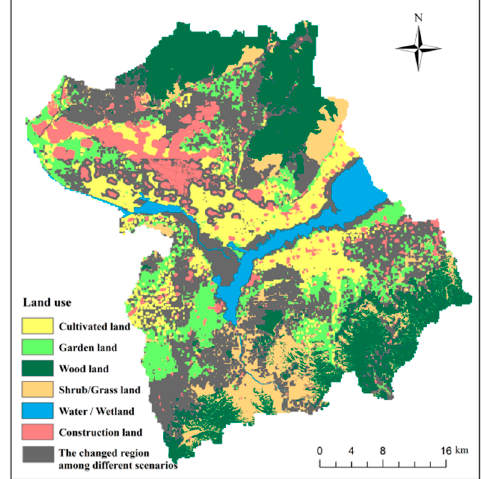
Figure 6. Changed land use region of Huailai County under different climate change scenarios.